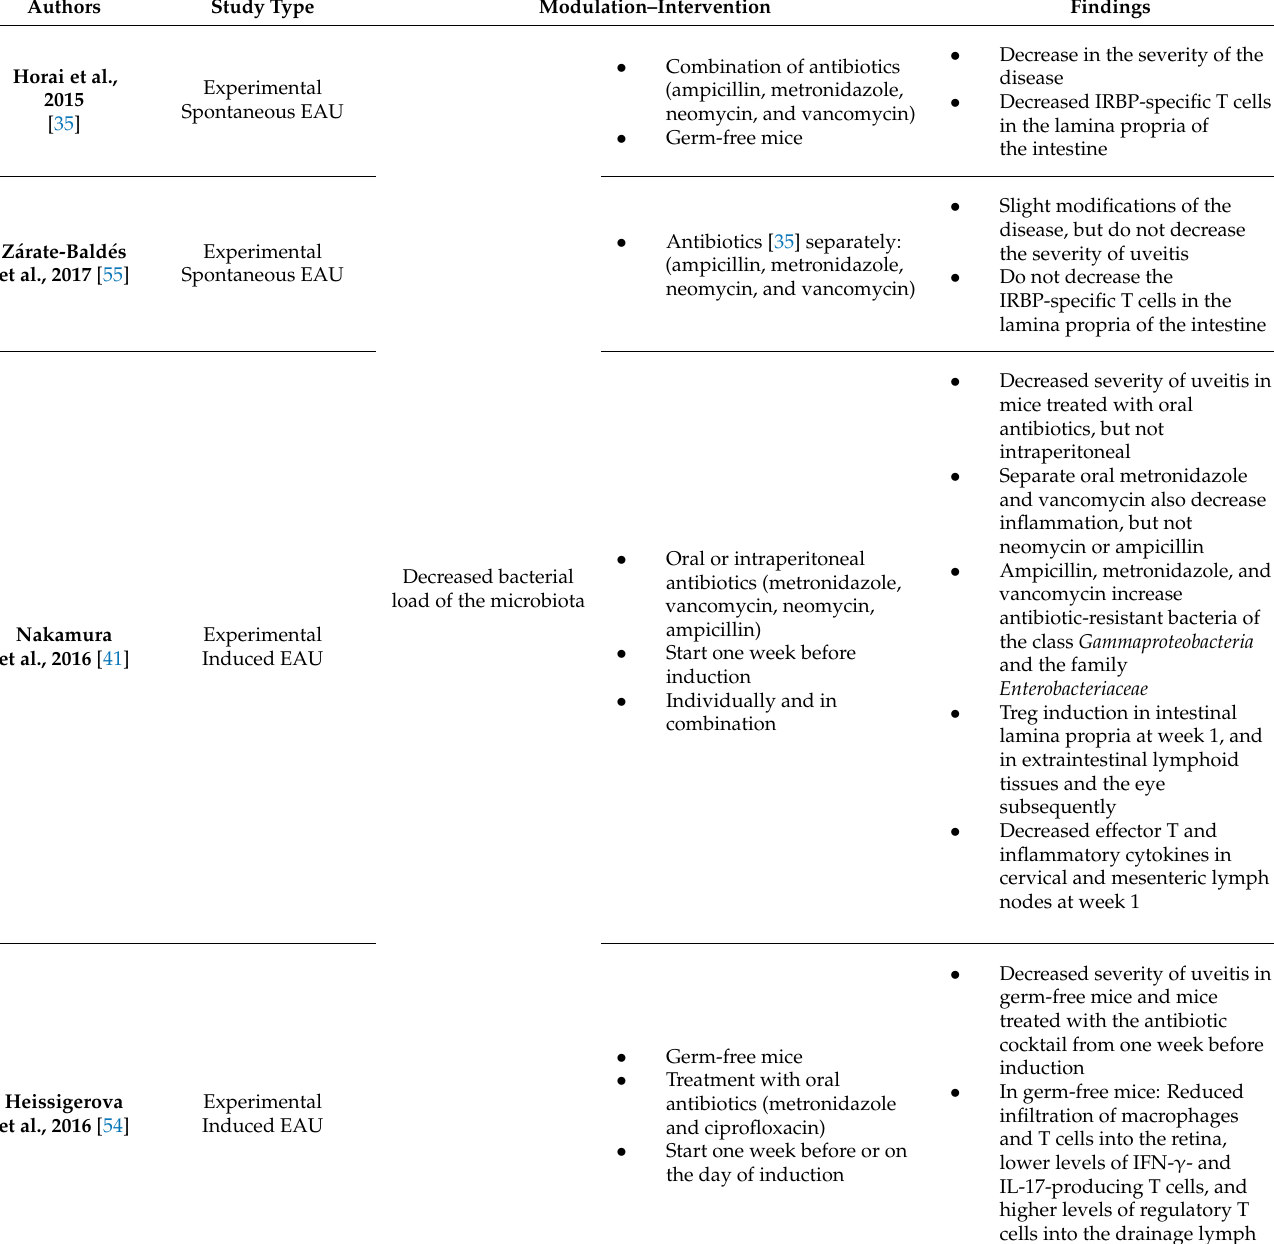
Table 1. Pre-clinical studies with experimental autoimmune uveitis